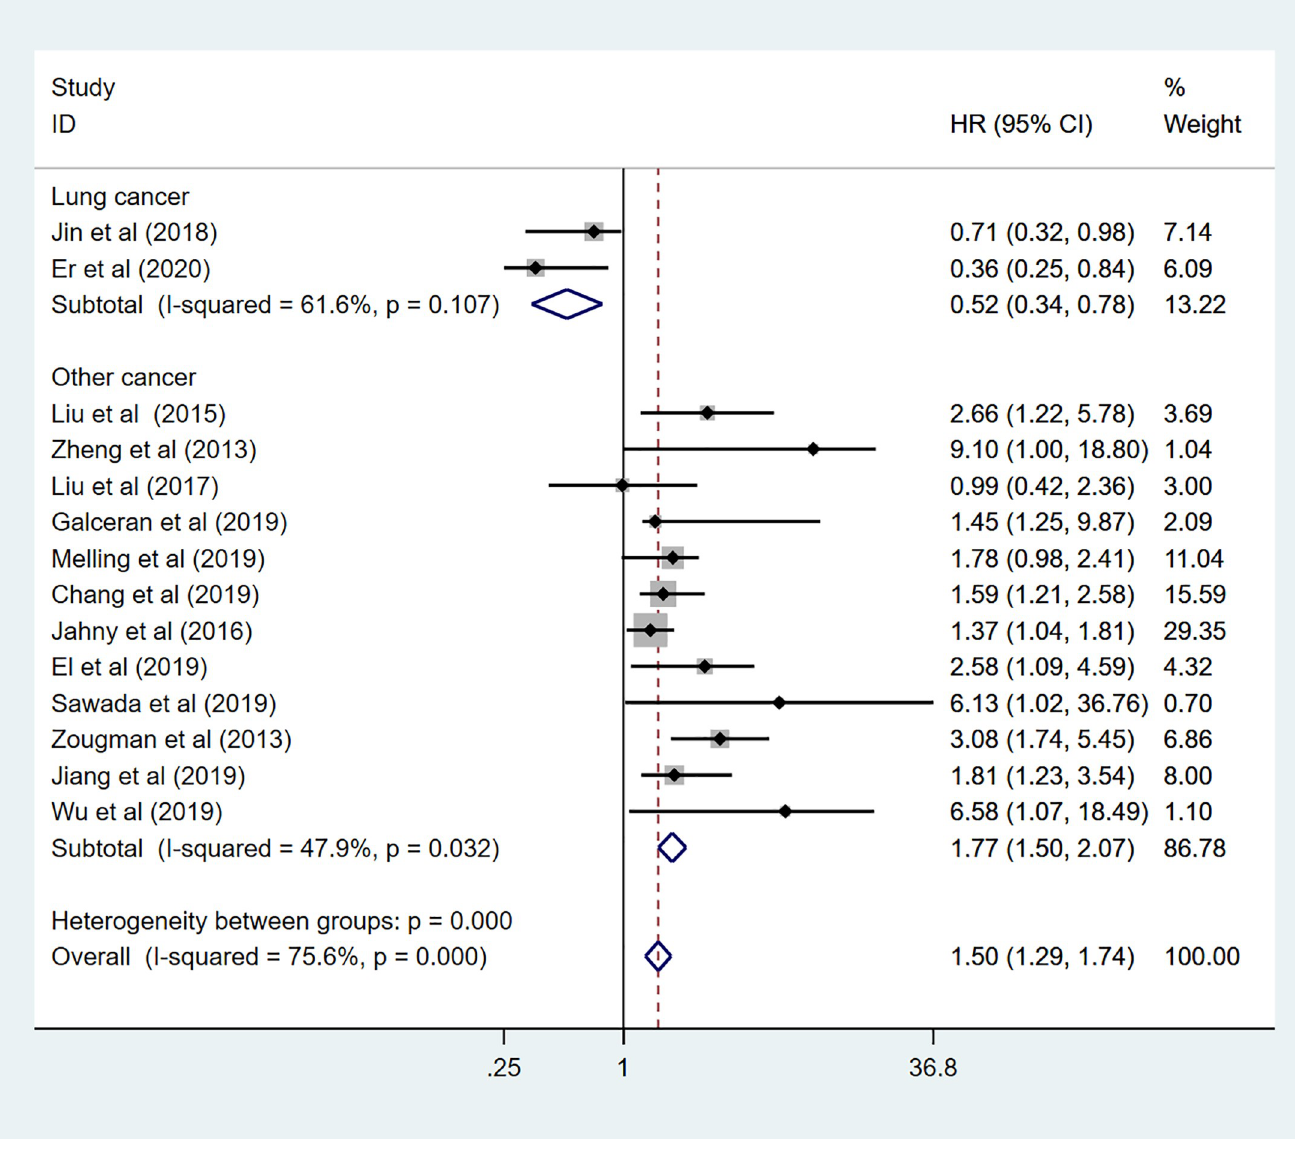
GPRC5A was significantly associated with poor prognosis in the majority of solid cancers studied such as pancreatic, gastric, prostate, hepatocellular and esophageal cancer, but no